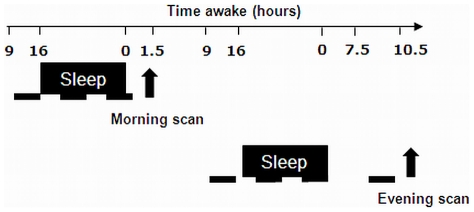
Overview of the experimental design.Subjects came to the lab 7 h before scheduled sleep time and stayed for 2 consecutive nights monitored via polysomnography (black box). They stayed under controlled light (<10 lux for wake periods and ≈0 lux for sleep periods) conditions and body posture (dashed lines). During wakefulness, sleepiness and vigilance measures were collected at hourly intervals as well as saliva samples (for melatonin assay). One and a half (morning session) and 10.5 (evening session) hours after scheduled wake up time subjects underwent an fMRI session while performing a Stroop task. Order of morning and evening sessions was counterbalanced between groups and subjects.